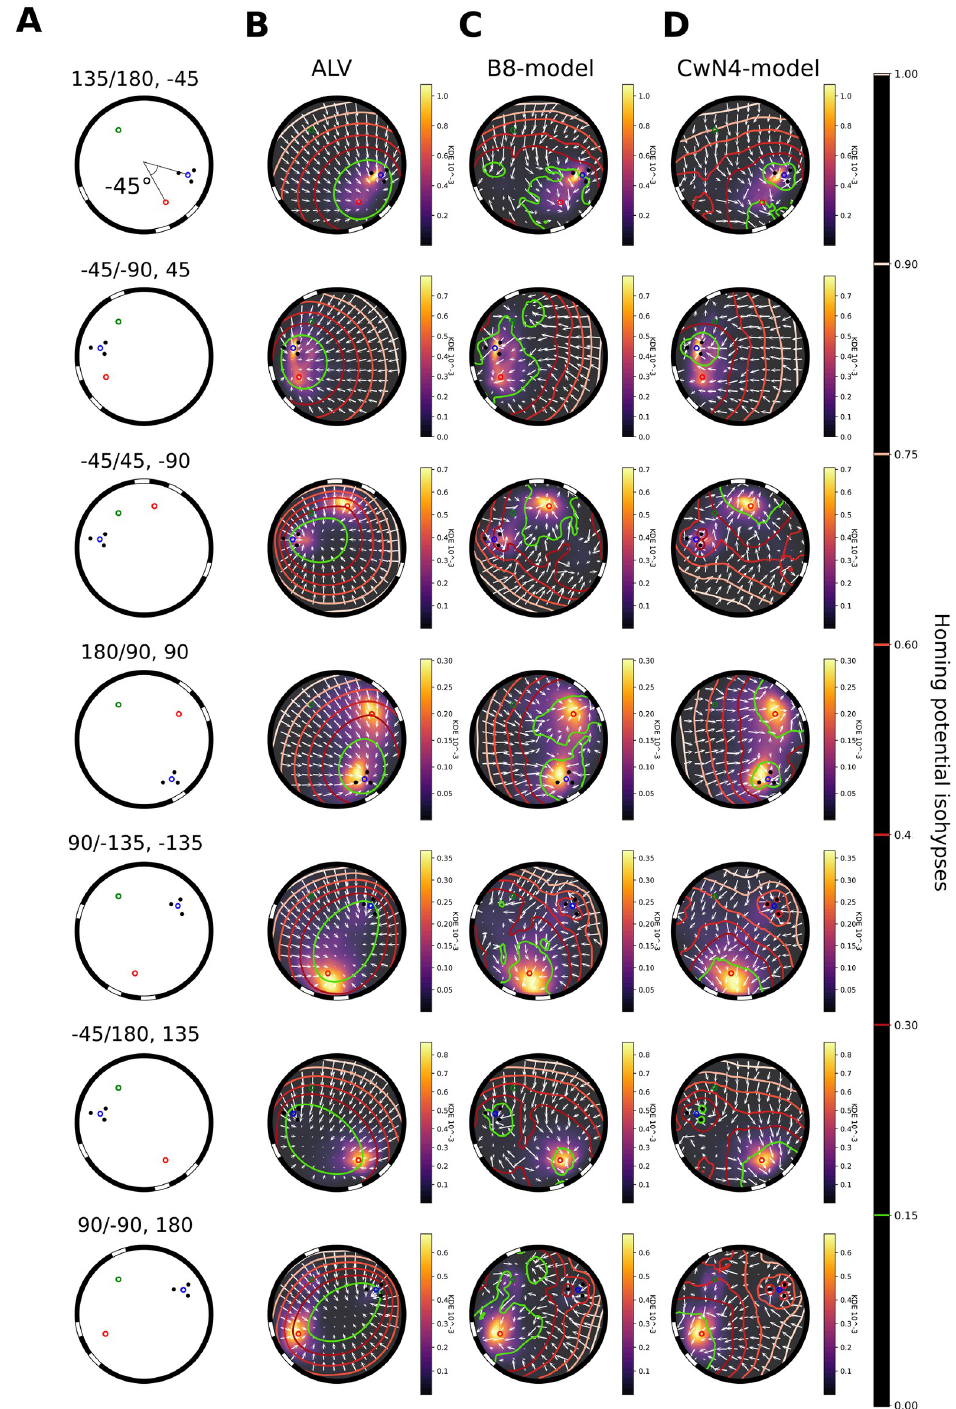
Fig 6. Qualitative models and behaviour comparison for different conflict conditions. A: Schematic of the set-up for the different conflict conditions. (BCD) The behaviour in the arena along the x and y axis of the arena is represented as a colour coded KDE from dark low distribution to yellow, high distribution. The vector fields of homing vectors for each model is represented on a 8-times downsampled grid by white arrows. Models results are expressed by an homing potential obtain from the Helmholtz-Hodge decomposition represented as contour lines or isohypses. The isohypse at 0.15 (basin) is coloured in green for clarity then the upper ones are coloured from dark red to white (“summit”). B: The ALV model for the 7 conditions, C: the B8-model, D: The CwN4-model.